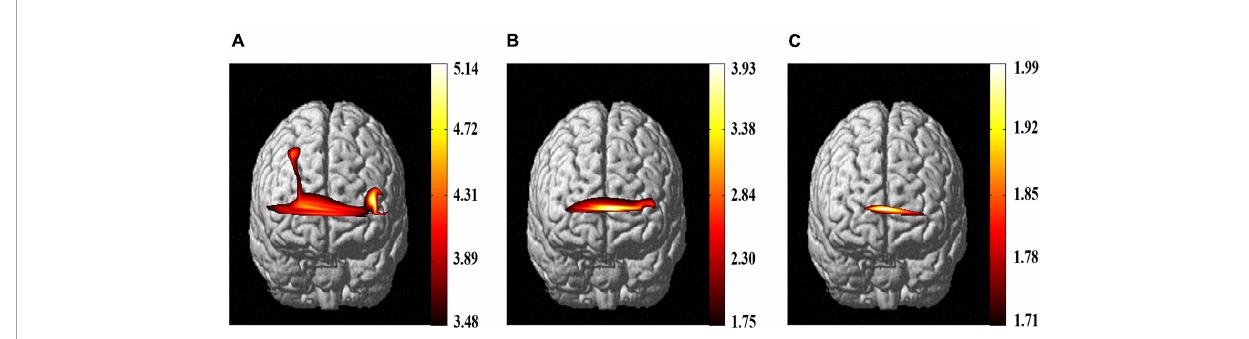
FIGURE6 Outcomes of brain activity in response to three pain tests. (A) The first pain test. (B) The second pain test. (C) The third pain test. The colored bars on the right graph indicate t- values.